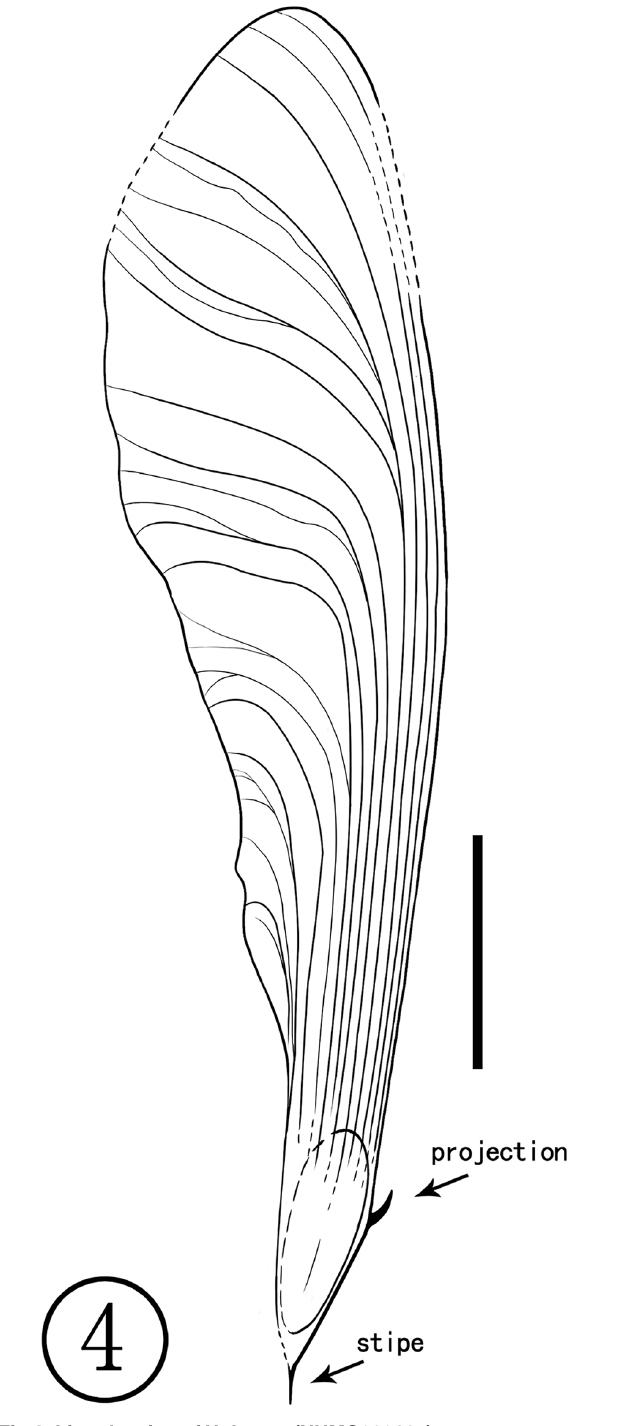
Fig 4. Line-drawing of Holotype (NHMG030165).